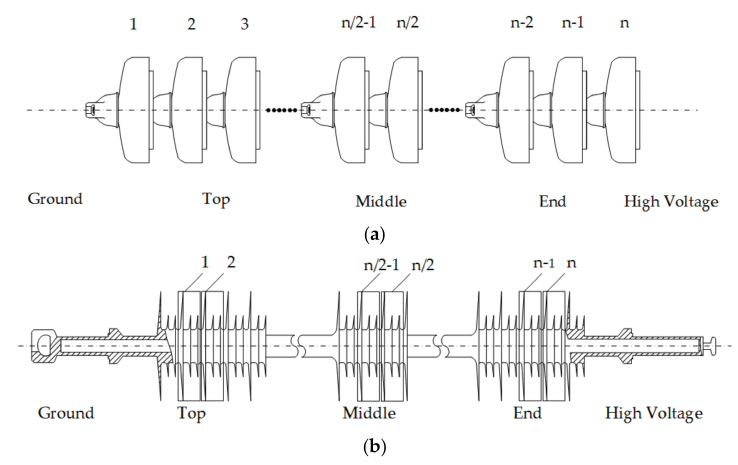
Figure 1. Insulator sampling diagram. ( a ) Suspension insulators; ( b ) long rod composite insulator.